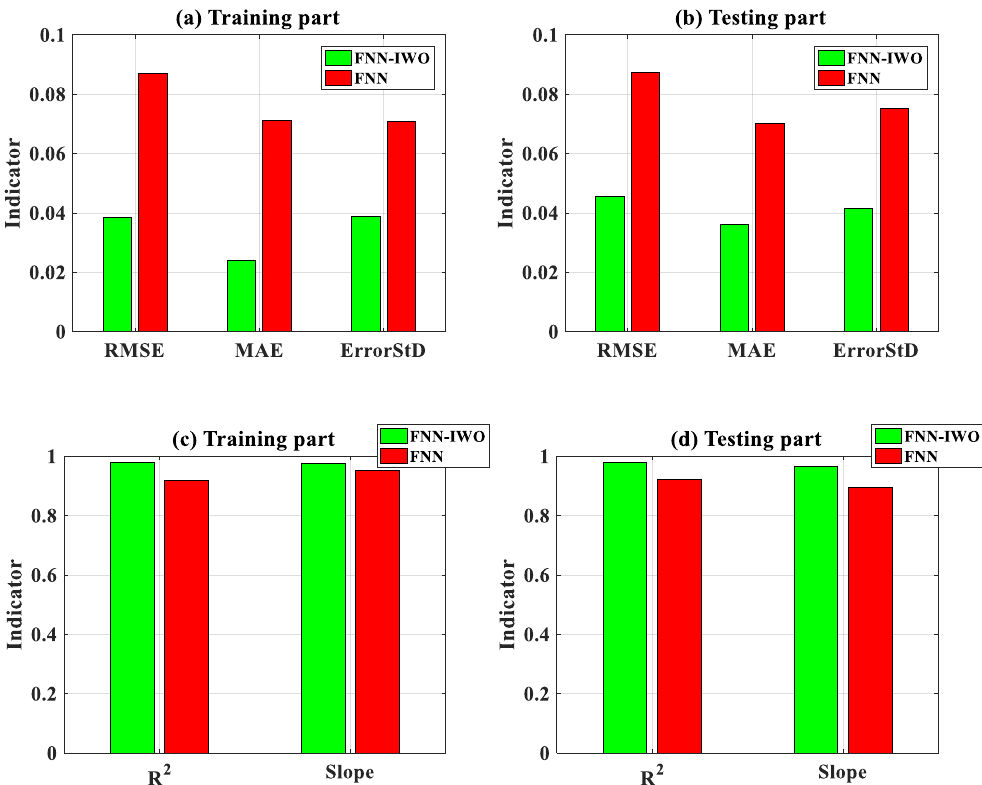
Figure 12. Comparison of performance indicators between the individual FNN and FNN–IWO model: